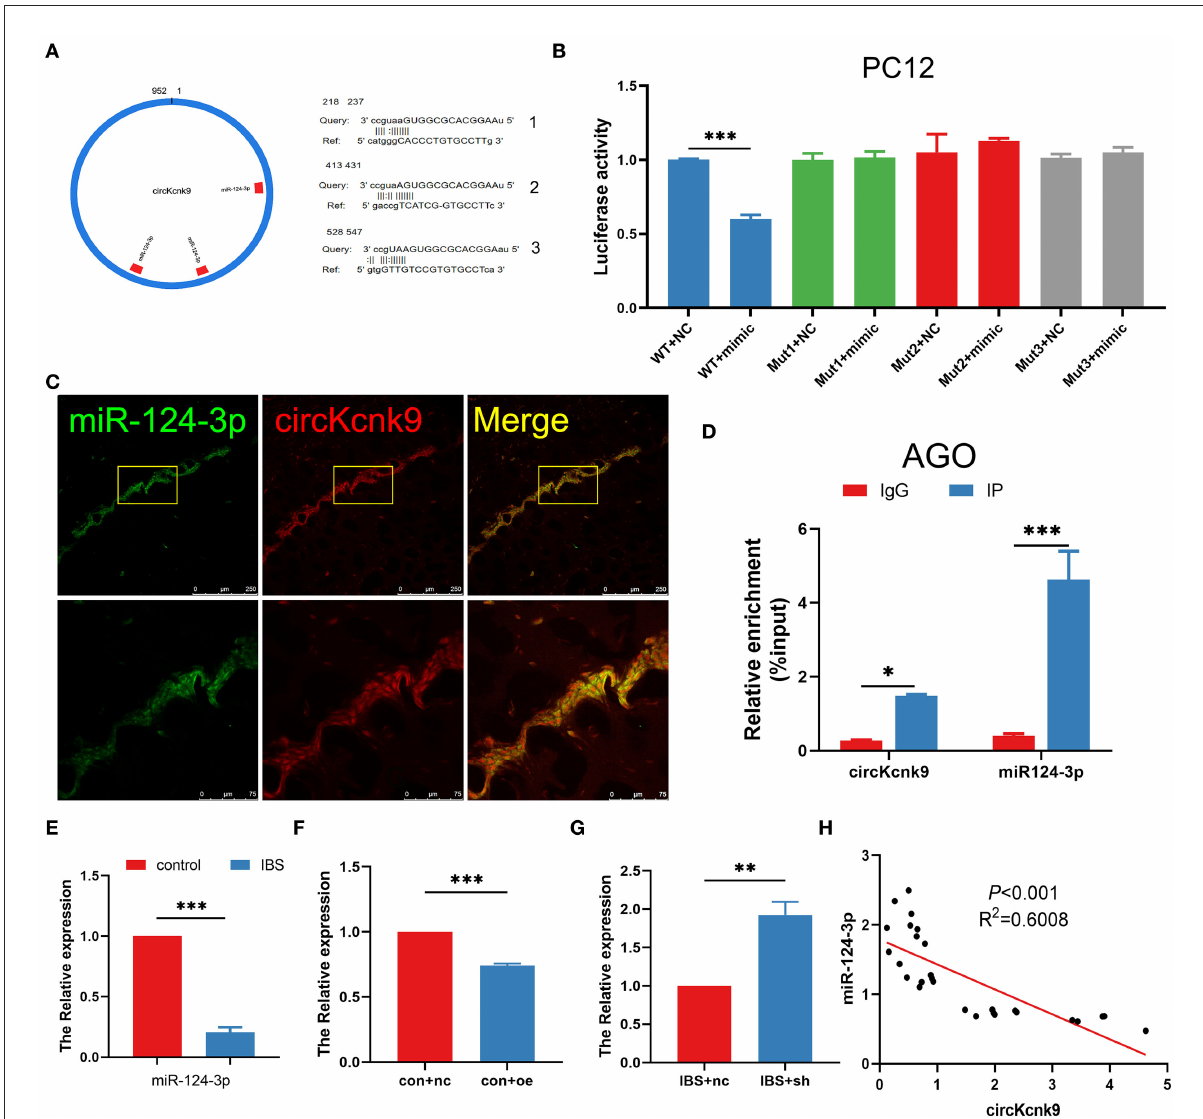
FIGURE4 CircKcnk9 acts as miR-124-3p sponge. (A) CircKcnk9 has three binding sites for miR-124-3p. (B) Double-luciferase reporter assay results showing circKcnk9 could bind to miR-124-3p. N = 3, *** p < 0.001. (C) Colocalization of circKcnk9 and miR-124-3p. Scale bar, 250 µ m. (D) AGO protein antibodies can coprecipitate circKcnk9 and miR-124-3p. N = 4, * p < 0.05, *** p < 0.001. (E) Lower expression of hippocampal miR-124-3p in IBS rats compared with that in controls. N = 8, *** P < 0.001. Expression of miR-124-3p after CA1 treatment with aav-circKcnk9 in controls (F) and shcircKcnk9 in IBS-like rats (G) . N = 6, ** p < 0.01, *** p < 0.001. ( H ) Correlation analysis of circKcnk9 and miR-124-3p ( p < 0.001, R 2 = 0.6008). AGO: the vital component of the RNA-induced silencing